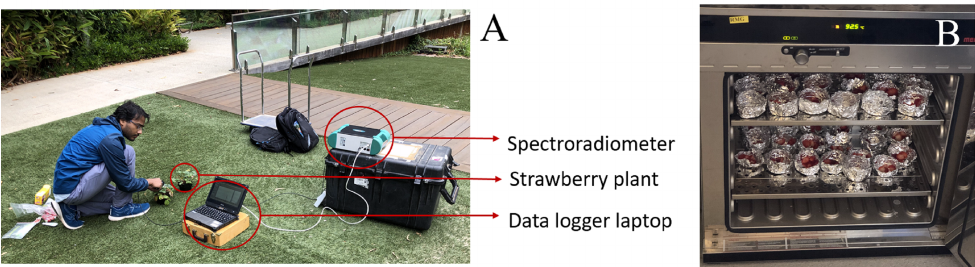
Figure 3. ( A ) Data collection from ASD spectroradiometer under natural sunlight conditions. ( B ) After the spectroradiometer data collection, the samples were weighed and placed in an oven with marked aluminum